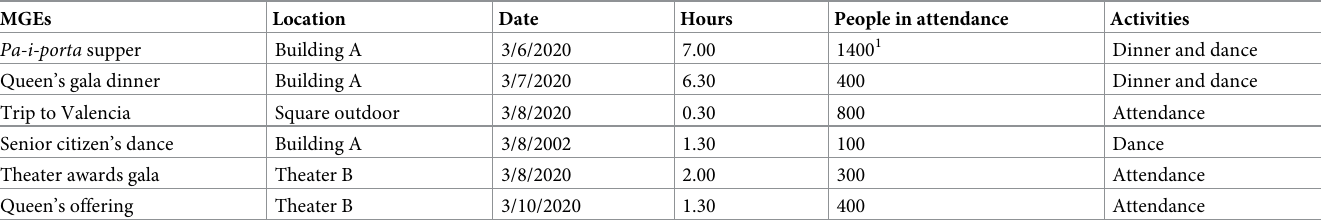
Table 1. Characteristics of Mass Gathering Events (MGEs) connected to the Falles festival in Borriana from March 6 to 10.